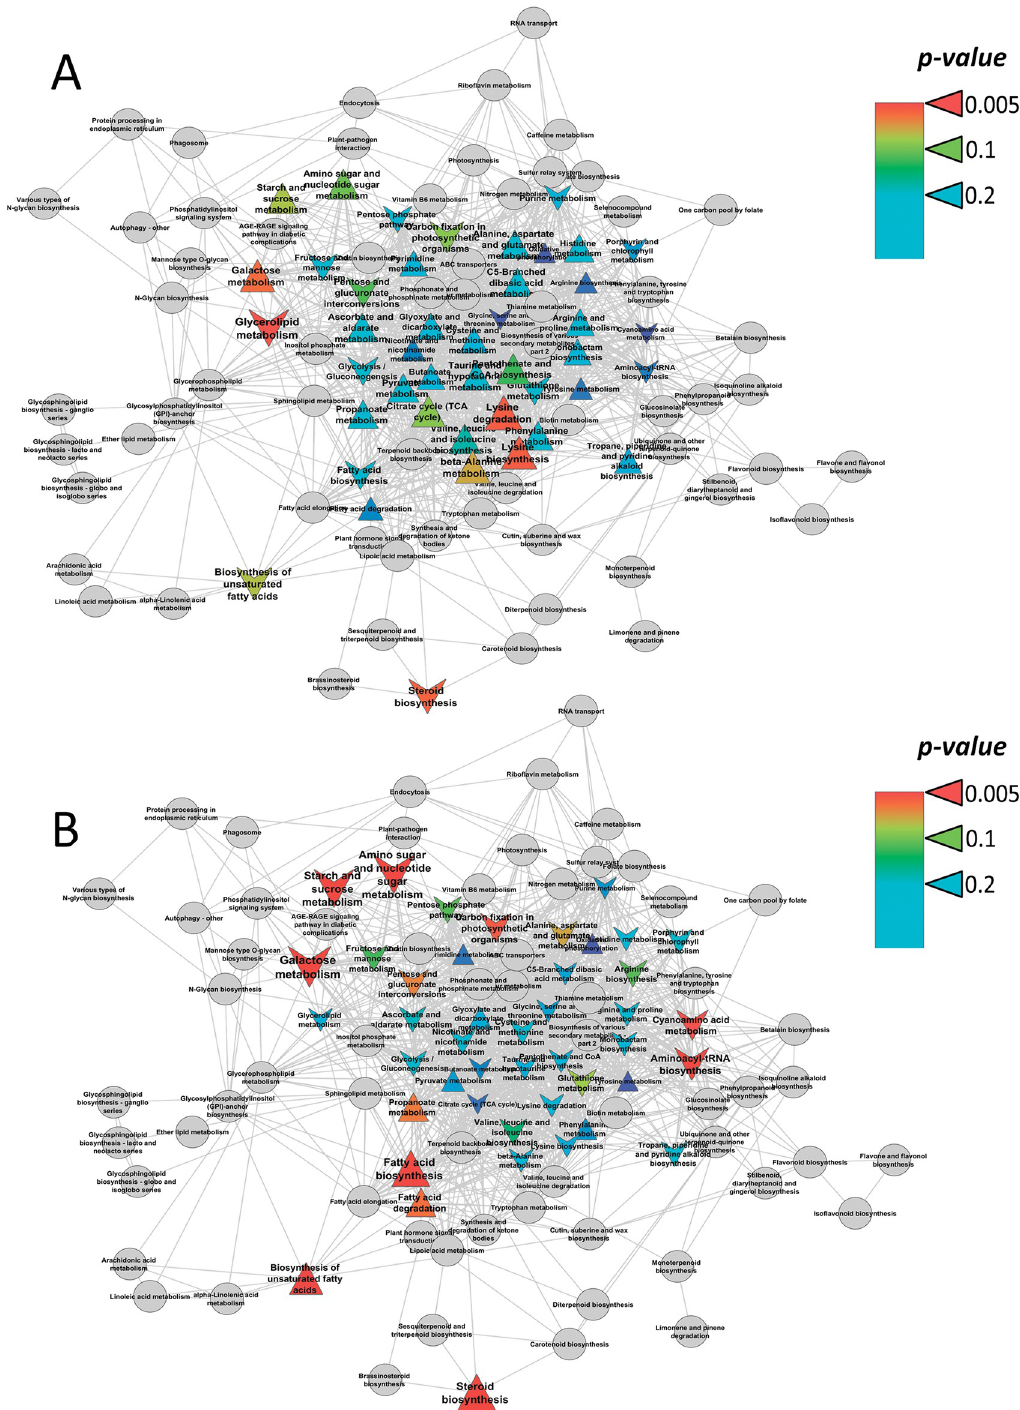
Fig 7. Enrichment analysis of the Fe deficiency effects on the leaf metabolism of cucumber grown hydroponically in a nutrient solution, either with/without +Fe III (A) or with/without Fe II (B). The graph represents a map of the biochemical pathways (nodes) connected by edges if they share common metabolites. The proximity of nodes determined from the number of common neighbours. Colours represent p -values, shape: Δ —activation under Fe starvation and v—repression under Fe starvation, sizes: The power of effect represented as